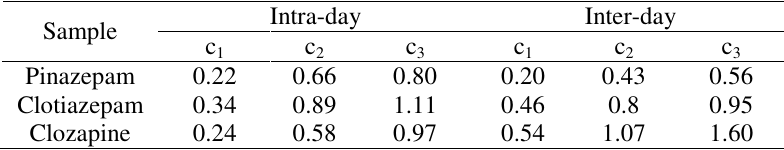
= 600, c = 300 and c = 150 ng mL -1 ) 1 2 3